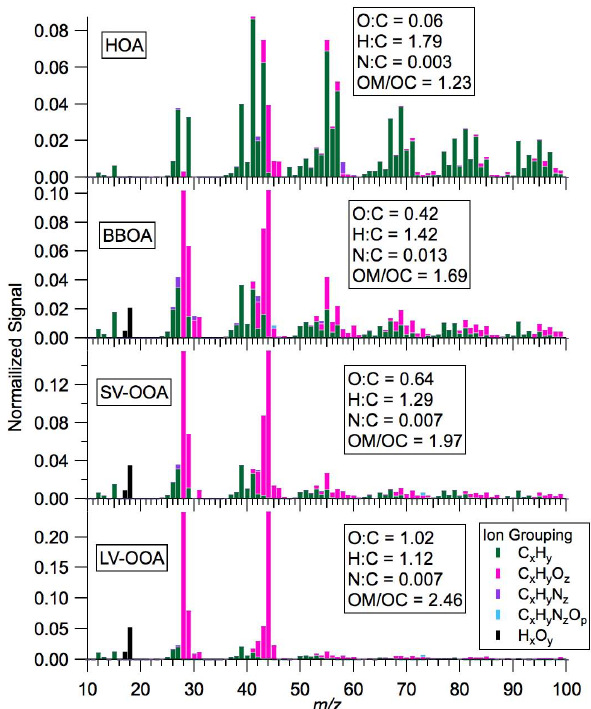
Fig. 5. Mass spectra of the 4 factor PMF solution with the corre- sponding elemental analysis of the mass spectra giving O/C, H/C, N/C atomic ratios and the OM/OC